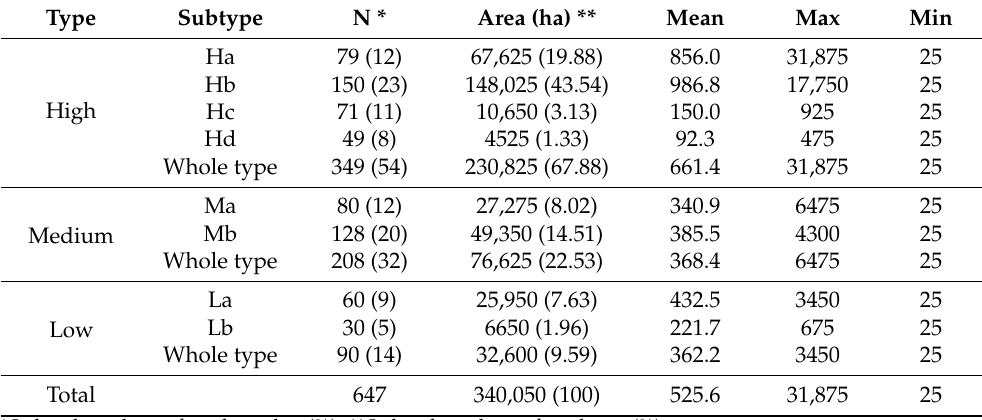
Table 1. Area characteristics (ha) of segments grouped into relief types and